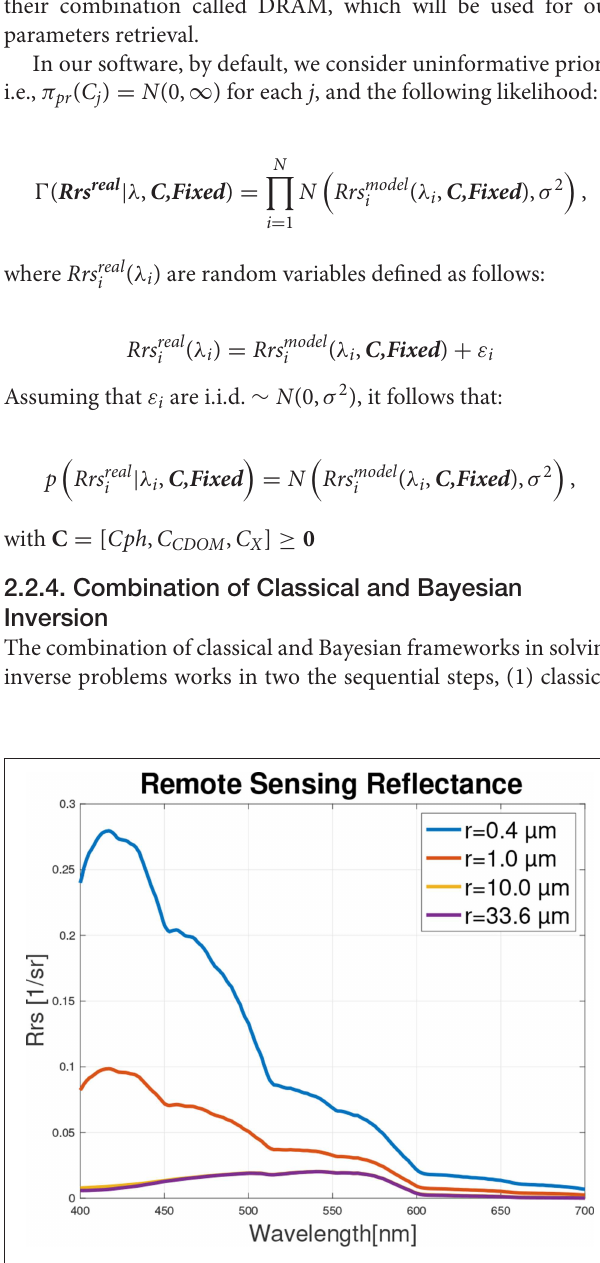
FIGURE 5 | Spectral remote sensing reflectance vs. wavelengths and SPM grain size, fixed